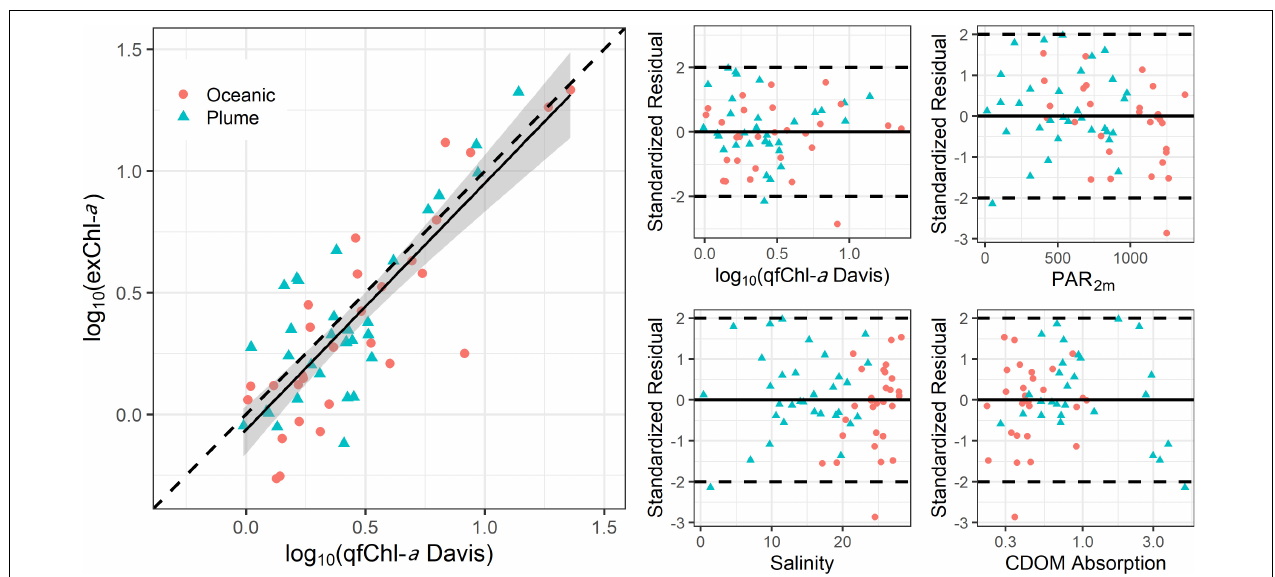
FIGURE 6 | Regression between log10 transformed qfChl- a Davis and HPLC (left) and standardized residual plots as a function of qfChl- a Davis , PAR 2m , CDOM absorption and salinity (right). The red circles are sampled from the plume and the blue triangles are sampled in oceanic waters. Note that data were log 10 transformed to account for the non-normal distribution of Chl- a (Seegers et al., 2018).